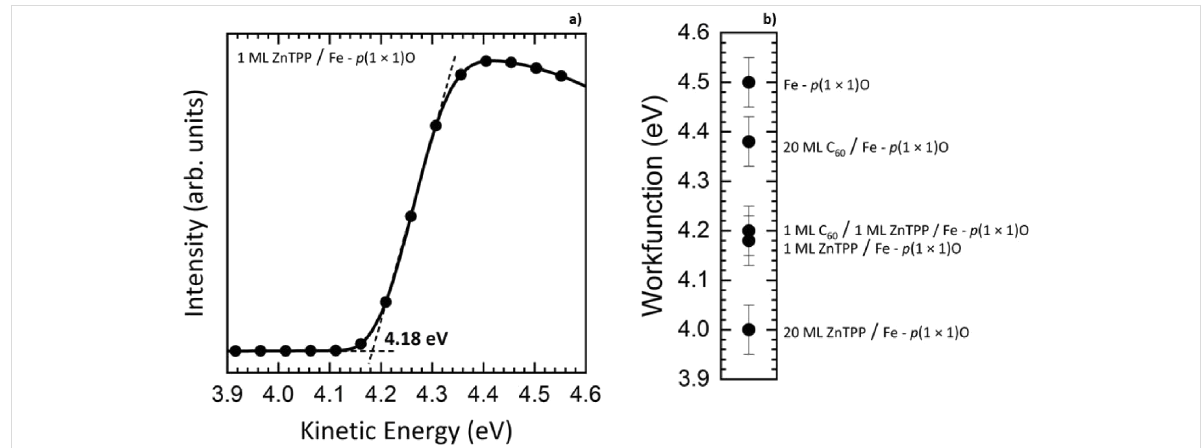
Figure 5: (a) Work function acquired on the system 1 ML ZnTPP/Fe(001)– p (1 × 1)O. The two dashed lines indicate how the onset of the curve is de- termined. The 10 eV offset due to the bias applied to the system has been subtracted. (b) Summary of the values of the work functions acquired on the system Fe(001)– p (1 × 1)O at different molecular coverages.